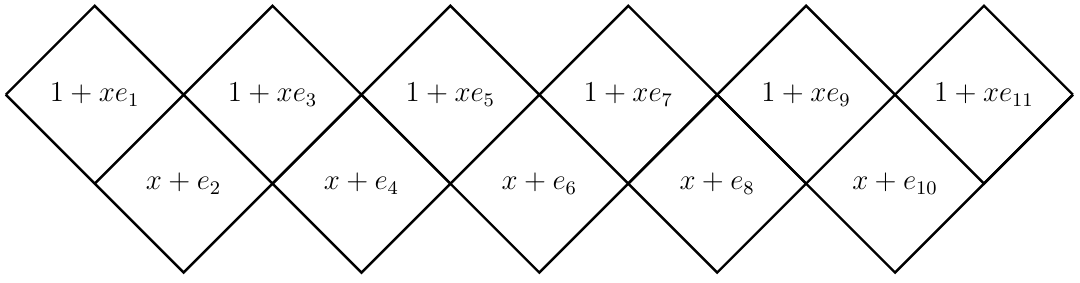
Figure 10 . The simpler transfer matrix T 1 defined in (3.39) with L = 6 . This transfer matrix is not integrable but describes the same model as the transfer matrix T is